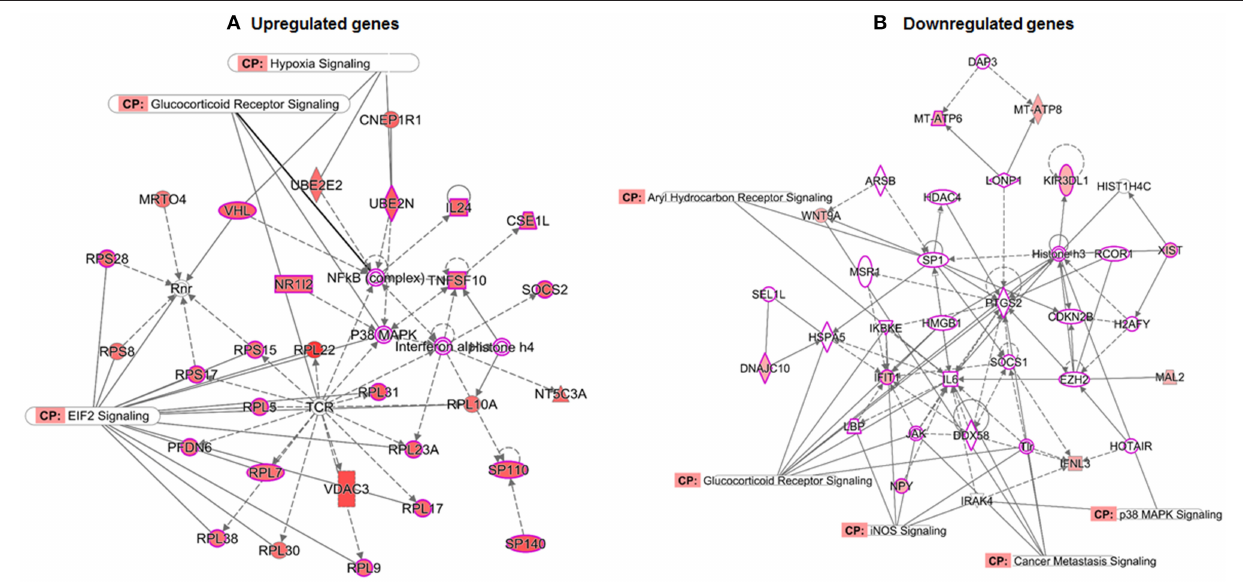
and metabolism. In our study, cytochrome c oxidase